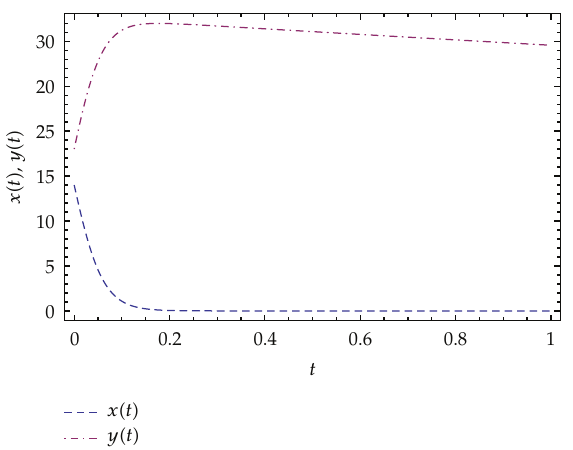
Figure 1: Population of x (cid:4) t (cid:5) and y (cid:4) t (cid:5) by RK4 (cid:4) h (cid:8) 0 . 0001 (cid:5) in case 1.